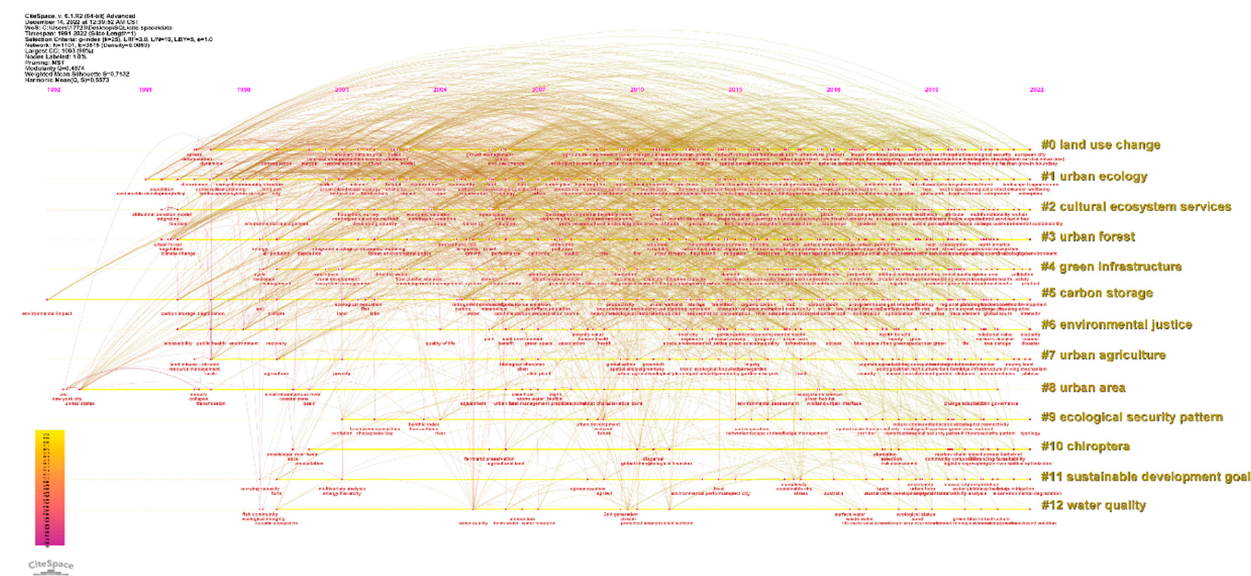
Figure 10. Clusters of UES research based on the keywords.